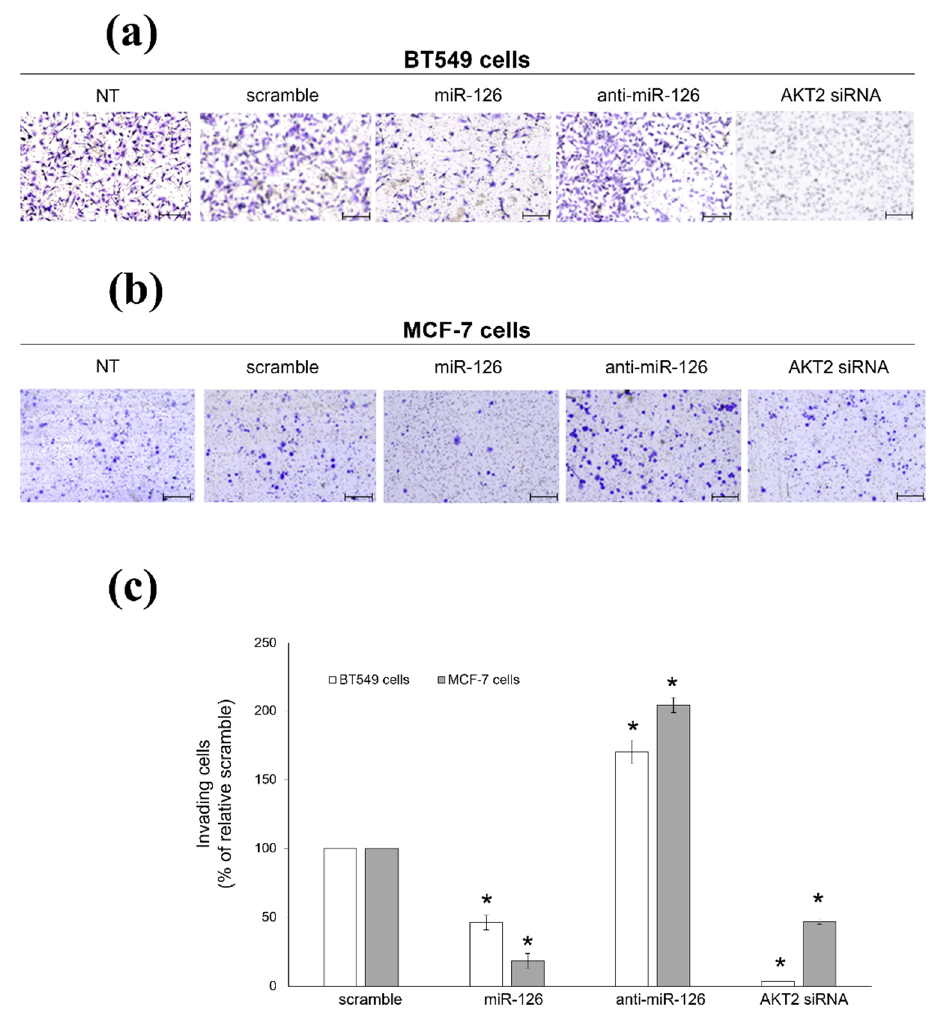
Figure 3. miR-126-3p/AKT2 axis reduces invasion of BC cells. Transwell migration assay performed with BT549 ( a ), and MCF-7 ( b ) cells left untreated (NT) or transiently transfected with either scramble oligo (scramble), miR-126-3p-mimic (miR-126), miR-126-3p-inhibitor (anti-miR-126), or AKT2 siRNA. Photographs are representative of four independent experiments. ( c ) Histograms show the number of invading cells, reported as percentage of relative scramble-transfected cells (not statistically differing from NT cells), arbitrarily set to 100% (absolute cell number = 608.12 ± 21.72 and 161.62 ± 14.67 for BT549 and MCF-7 cells, respectively). Data are shown as mean ± SEM. *: p < 0.01 versus relative scramble. Scale bars: 250 µm.